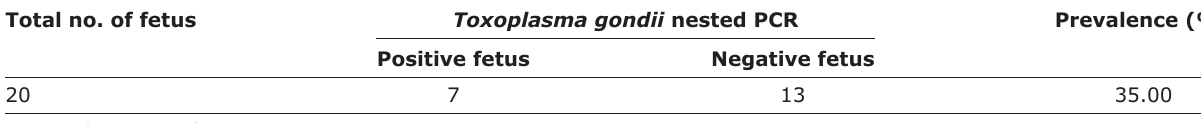
Table-2: Toxoplasma gondii in aborted fetus of goat based on nested PCR. Total no. of fetus